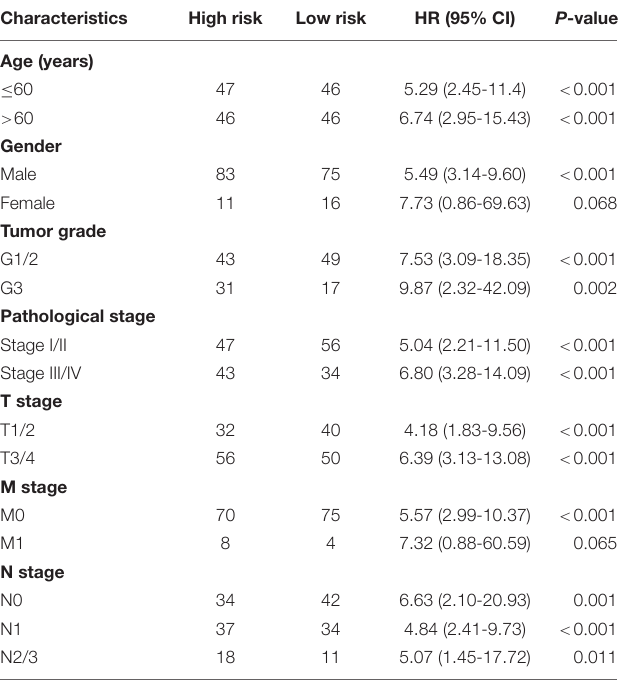
TABLE 3 | Analysis of the final AS signature in stratified ESCA cohorts.